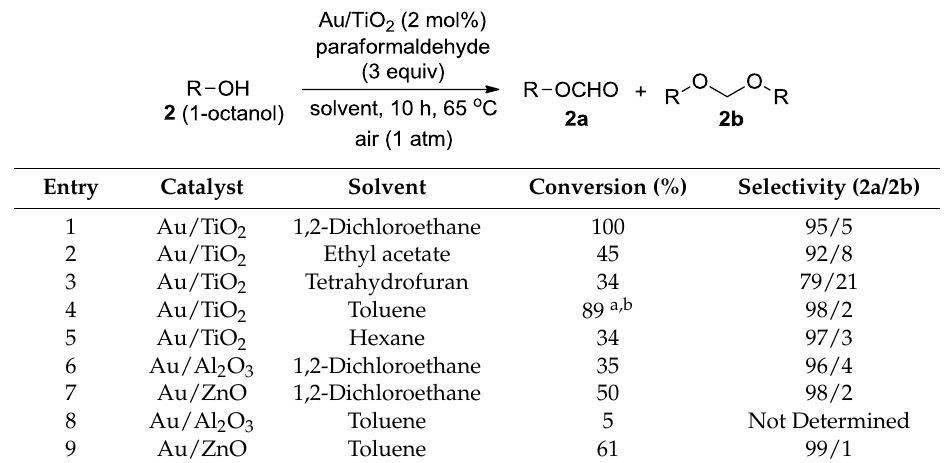
Table 1. Optimization of conditions regarding the Au nanoparticle-catalyzed formylation of 1-octanol ( 2 ) with paraformaldehyde.